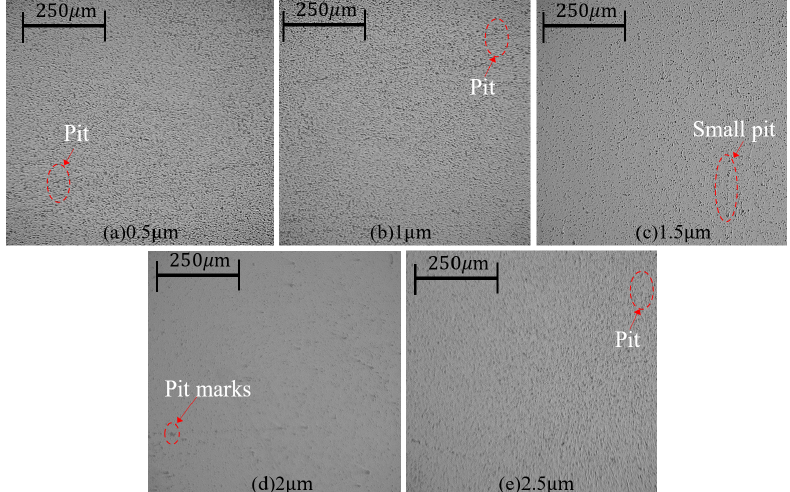
Figure 10. Microscopic appearance of samples with different particle